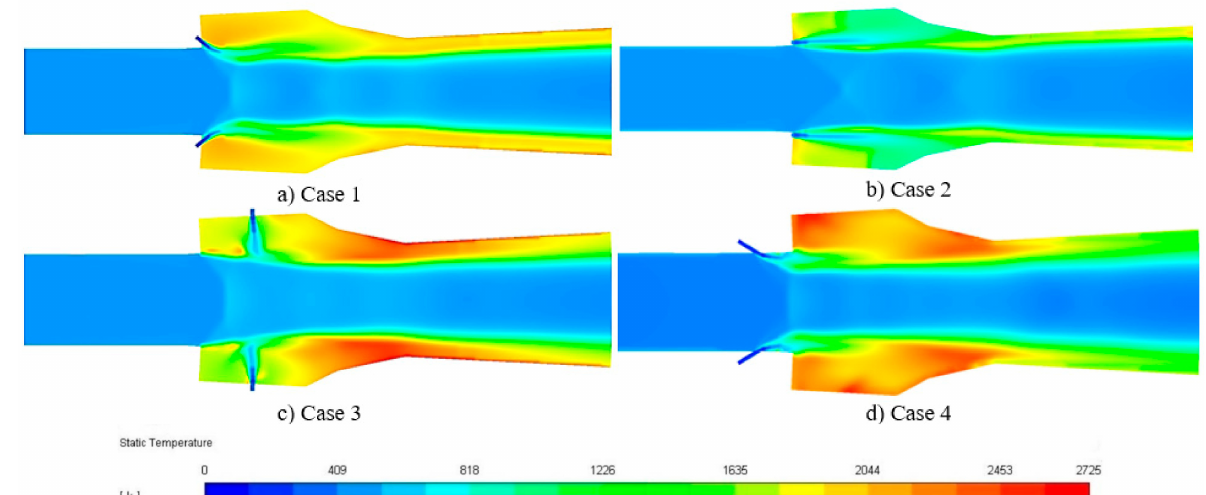
Figure 10. Temperature contour for the various injection schemes.